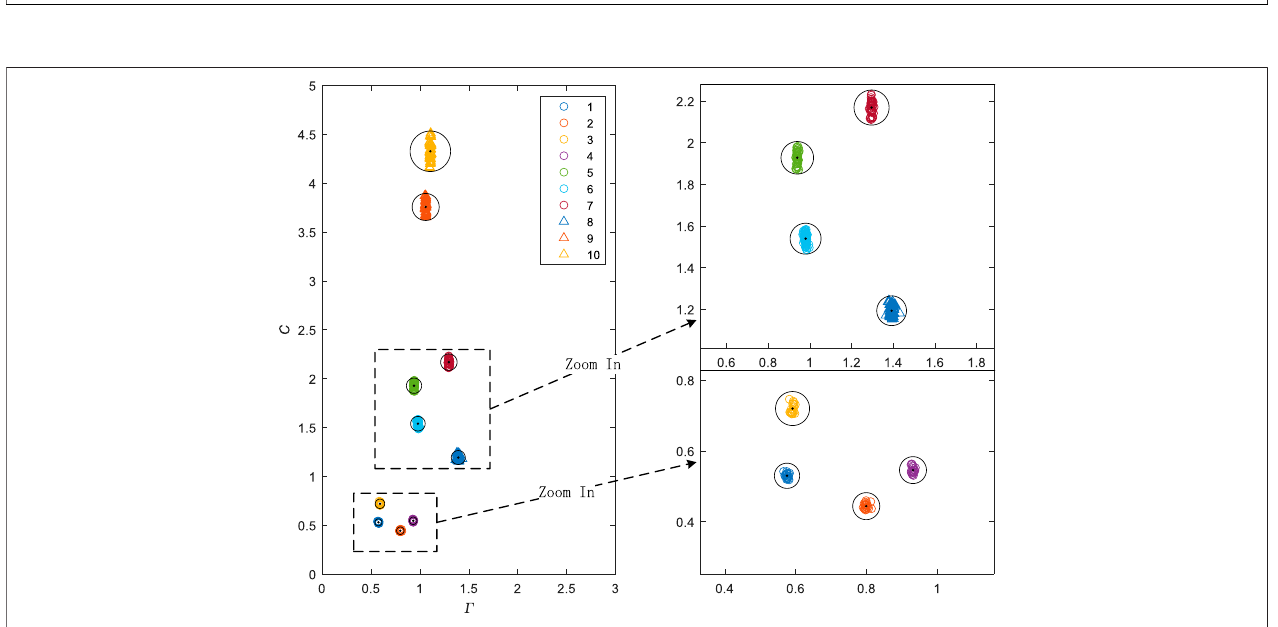
FIGURE 10 | Motor feature-hoods of the factory.